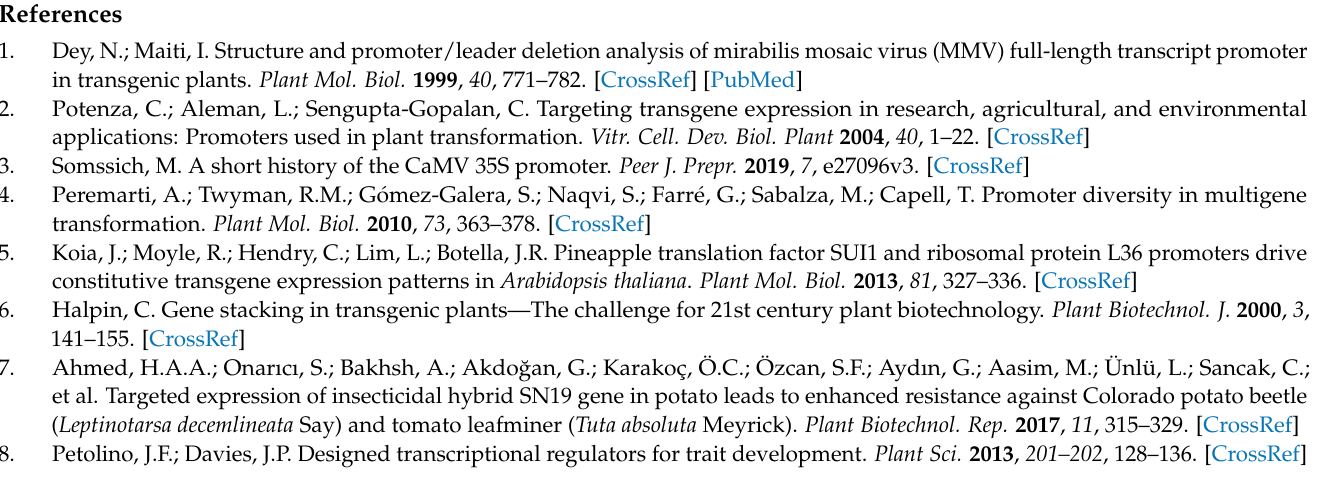
constructs. Table S2: Overrepresentation of the transcription factor (TF)-family binding domains on pAsr1 1875 promoter and their functional